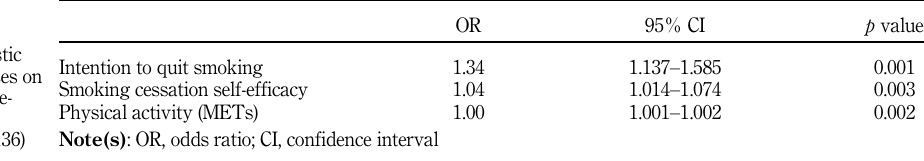
Table 3. Correlation coefficients and relationship between predictors; it shows by correlation matrix